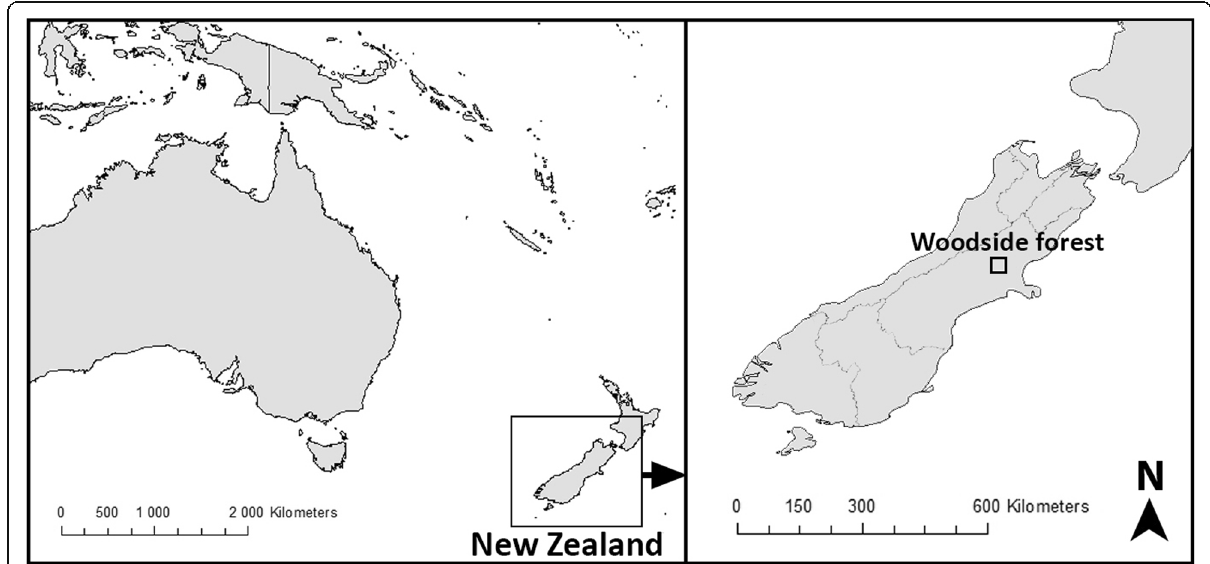
Fig. 1 Location of New Zealand ’ s South Island and the Woodside